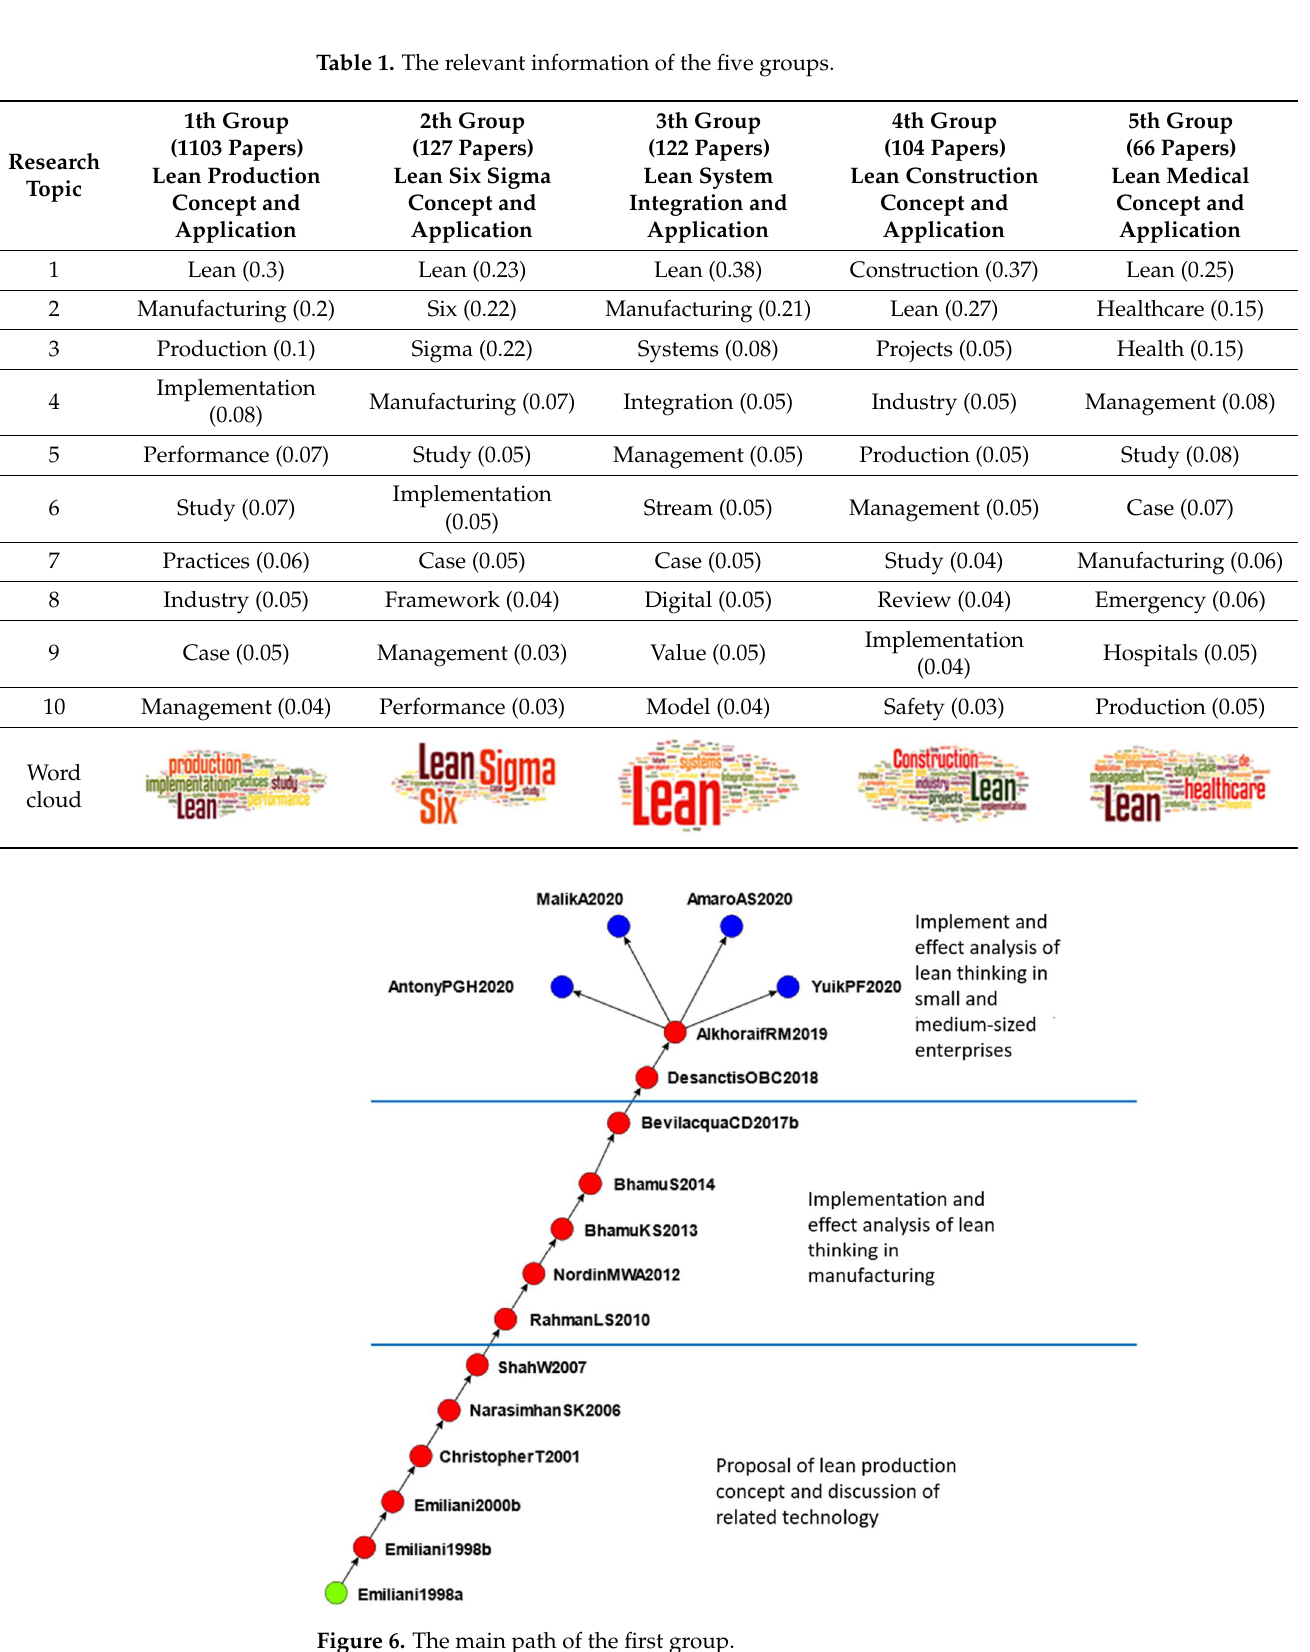
Table 1. The relevant information of the five groups.